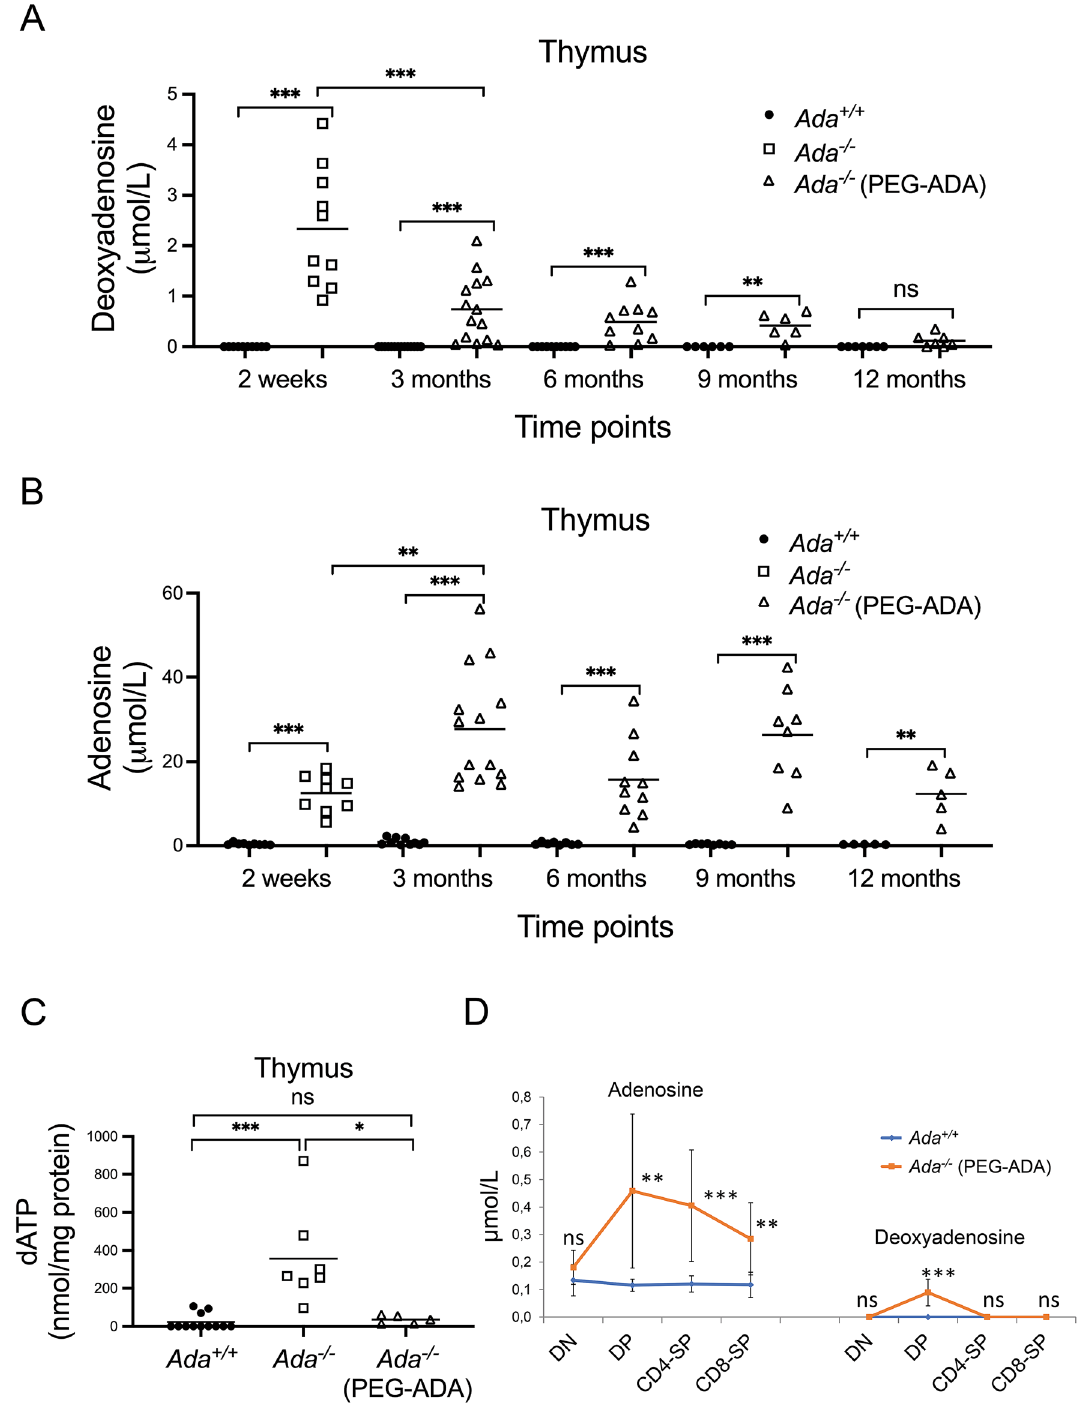
Figure 5. Incomplete detoxification of ADA metabolites in thymocytes from PEG-ADA-treated mice. Tandem MS measurement of dAdo ( A ) (2 weeks, n = 10, 10; 3 month, n = 14, 14; 6 months, n = 10, 10; 9 months, n = 5, 5; 12 months, n = 6, 6) and Ado ( B ) (2 weeks, n = 9, 9; 3 month, n = 10, 14; 6 months, n = 8, 10; 9 months, n = 8, 8; 12 months, n = 5, 5) levels in unfractionated thymocyte populations from control ( Ada + / + ), untreated and PEG-ADA-treated Ada −/− mice at different time points. ( C ) Reversed phase HPLC measurement of dATP levels of unfractionated thymocyte populations from control ( Ada + / + ), untreated (2 weeks) and PEG-ADA-treated Ada −/− (6 months) mice (n = 12, 7, 5). Plots in (A-C) were generated by GraphPad Prism 7 software. ( D ) Tandem MS measurement of Ado and dAdo levels in FACS-sorted thymocyte populations from control ( Ada + / + ) and PEG-ADA-treated Ada −/− mice at 6-month-time point (n = 6, 8). Bars represent mean values. * P < 0.05, ** P < 0.01 and *** P < 0.001. NS = statistically not